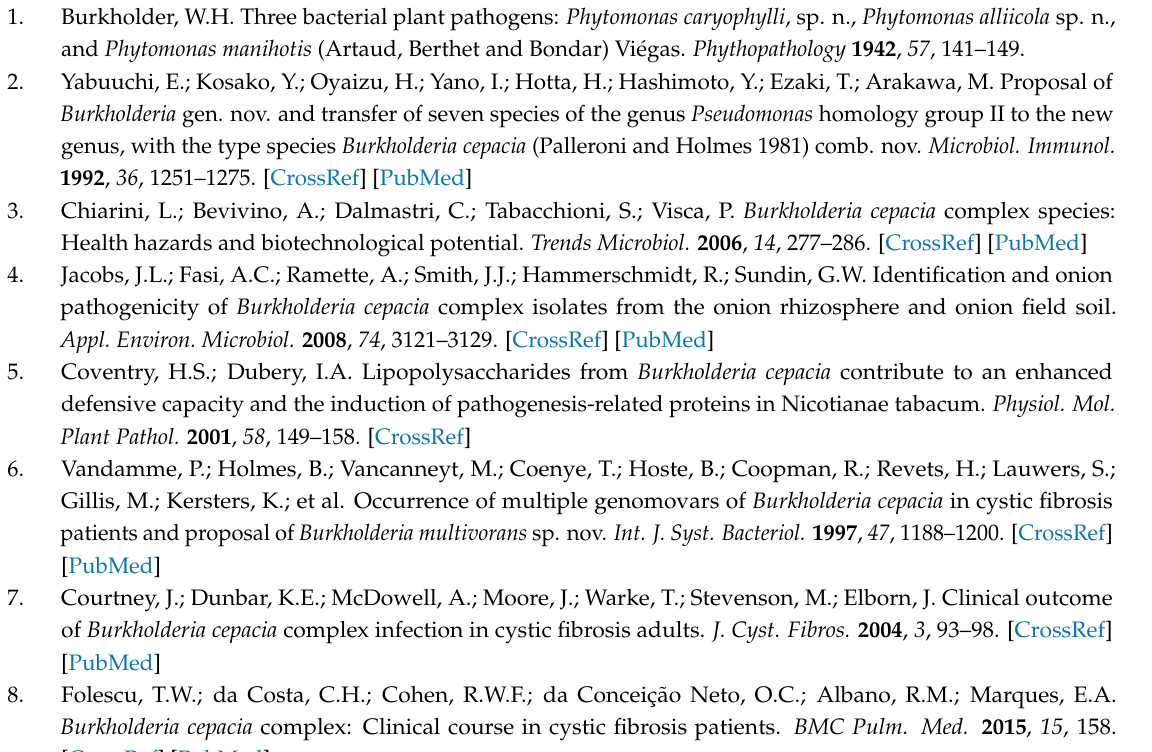
linear maps, Figure S3: DWS 37E-2_chr1_1 linear maps, Figure S4: VC12308_chr1_1 linear maps, Figure S5: FL-5-3-30-S1-D7_chr1_2 linear maps, Figure S6: 895_chr1_1 linear maps, Figure S7: 895_chr1_2 linear maps, Figure S8: 895_chr1_3 linear maps, Figure S9: 895_chr1_7 linear maps, Figure S10: 895_chr1_9 linear maps, Figure S11: 895_chr2_1 linear maps, Figure S12: MSMB384WGS_chr1_2 linear maps, Figure S13: CR 318_chr1_1 linear maps, Figure S14: MC0-3_chr1_1 linear maps, Figure S15: DDS 22E-1chr1_2 linear maps, Figure S16: VC7848_chr1_2 linear